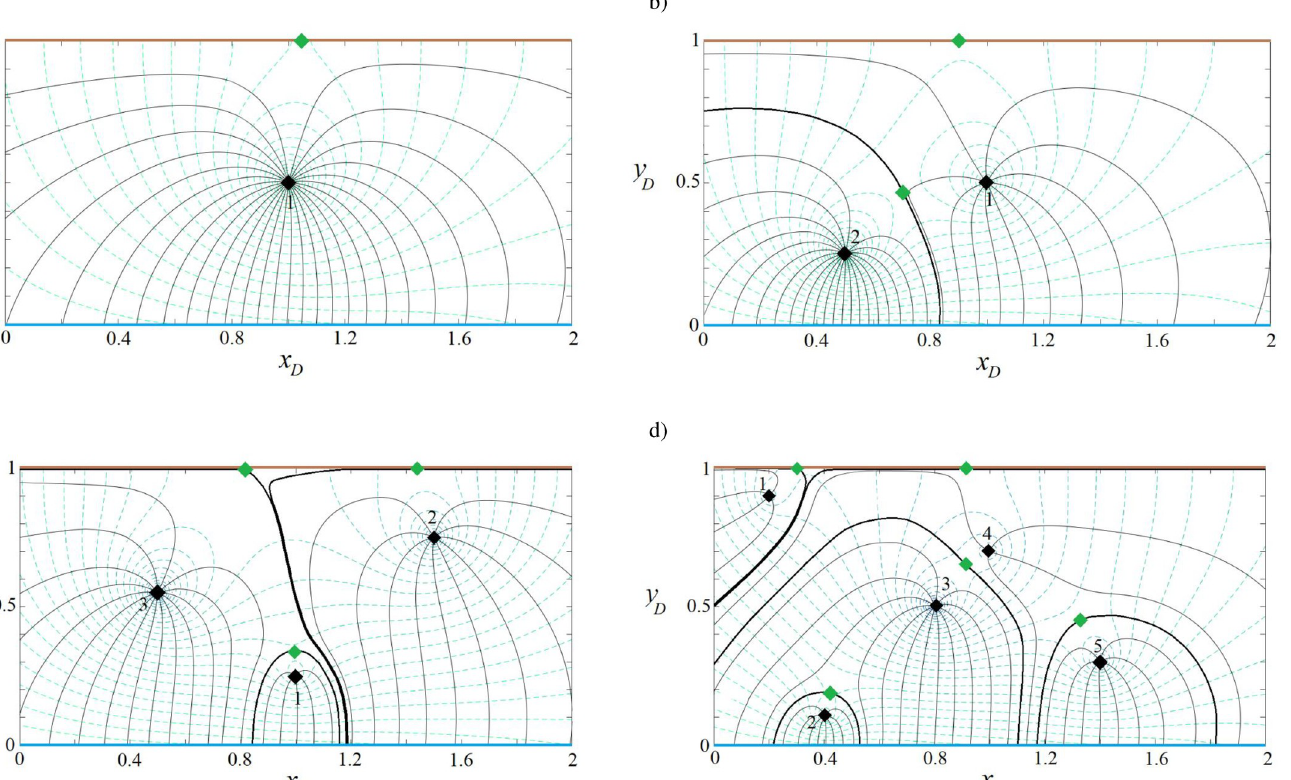
PLOS ONE | https://doi.org/10.1371/journal.pone.0229767 March 5,